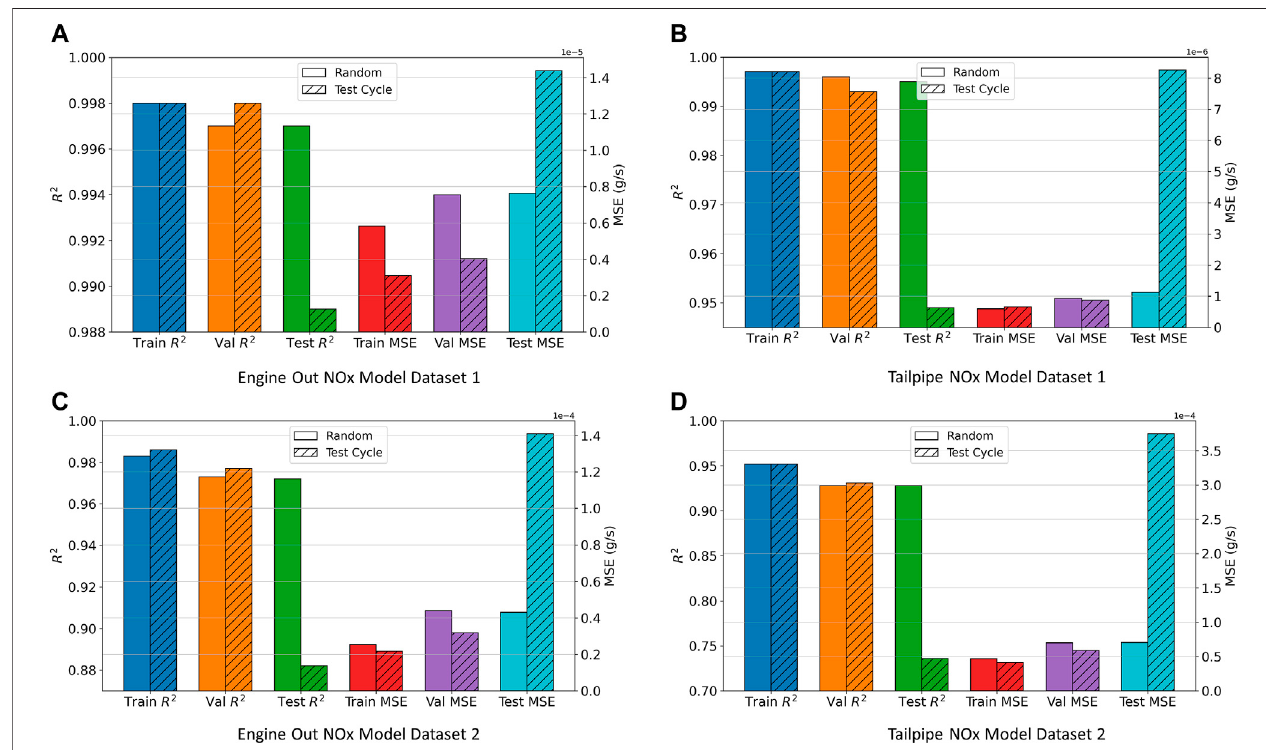
FIGURE8 | Effectoftype ofdata spliton model performance. (A) Engine Out NOxModel Dataset 1. (B) TailpipeNOx Model Dataset 1. (C) Engine Out NOxModel Dataset 2. (D) Tailpipe NOx Model Dataset 2.